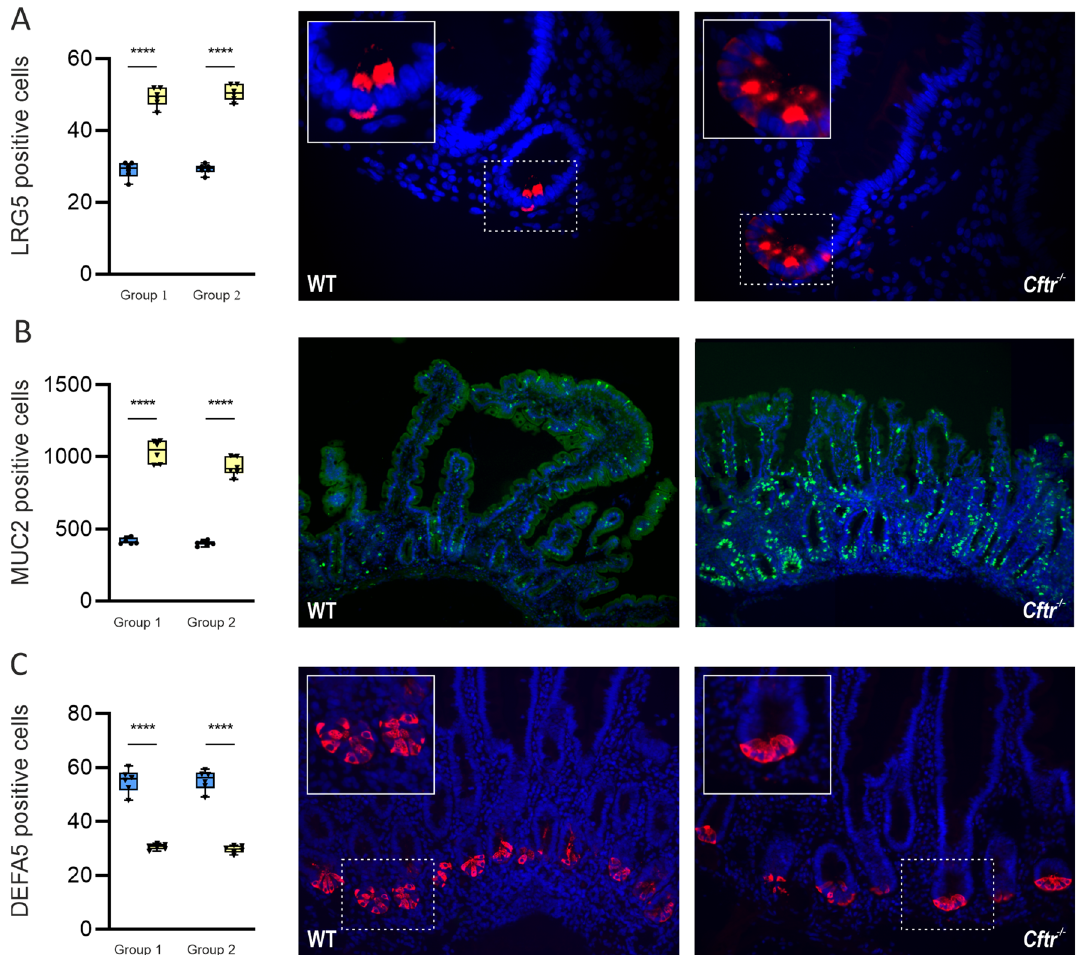
Figure 4. Expression of stem, goblet and Paneth cells in mouse ileal tissue. Quantification of cell numbers and representative images of ( A ) stem cells (leucine-rich repeat- G-protein coupled receptor 5, LRG5) positive cells stained red; ( B ) goblet cells (mucin-2, MUC2) positive cells stained green and ( C ) Paneth cells (defensin 5, DEFA5) positive cells stained red in wild-type (blue square, blue) and CFTR-null ( Cftr −/− ) (yellow inverted triangle, yellow) mice from group 1 and group 2. Nuclei are stained blue with 4 ′ ,6-diamidino-2-phenylindole (DAPI). Box and whisker plots represent the number of cells counted expressing LRG5, MUC2 and DEFA5 as median ± 95% CI (n = 6 for each mice group). Statistical significance was determined by One-way ANOVA with differences between means identified, using Tukey’s multiple comparison post hoc test; **** P < 0.0001. Images are 400 × ( A ), 100 × ( B ) and 200 × ( C ) magnified. The insets enclosed in white boxes show higher magnification images of the areas enclosed by the dashed